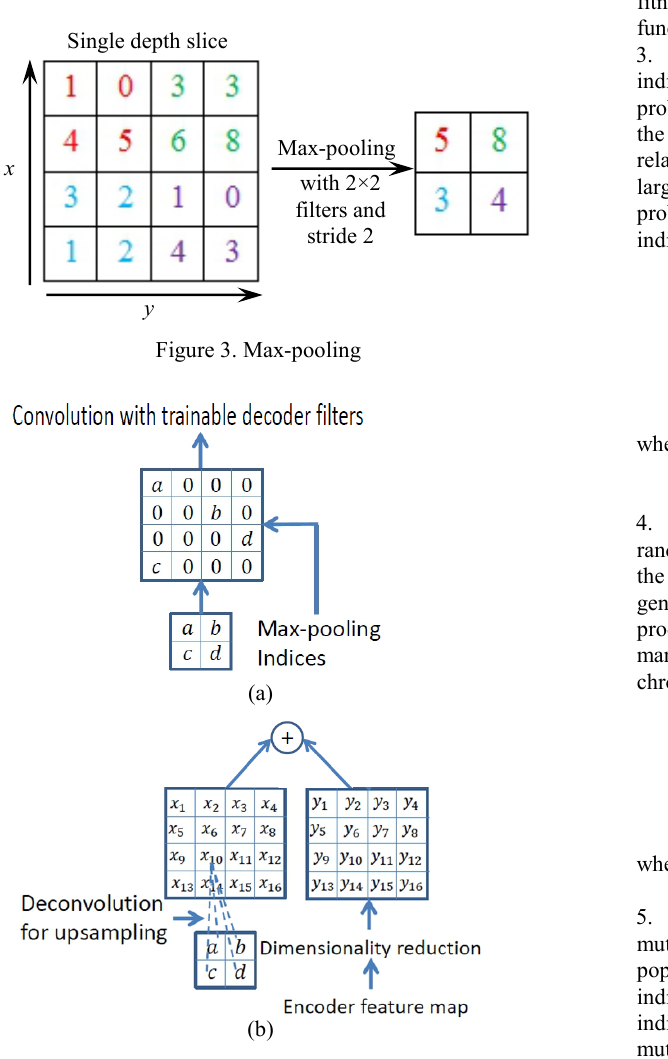
Figure 4. Upsample operation comparison between SegNet (a) and FCN